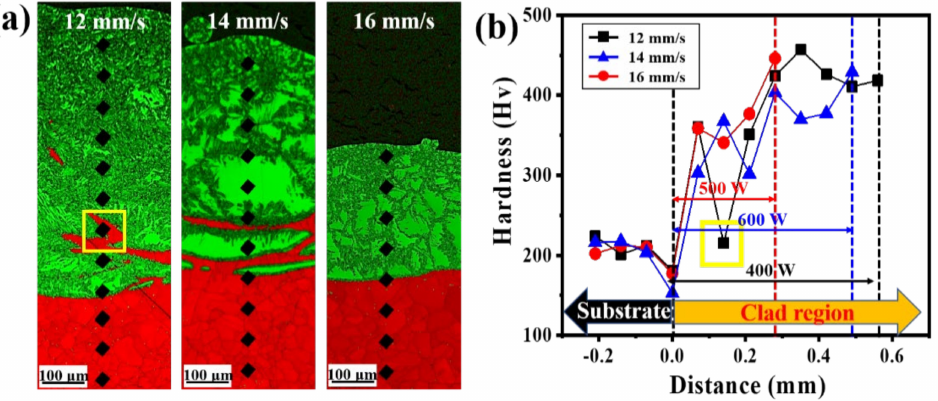
Figure 7. Hardness behavior for various laser traverse speeds (12 − 16 mm/s): ( a ) hardness measure- ment area, ( b ) hardness distribution in the clad specimens.